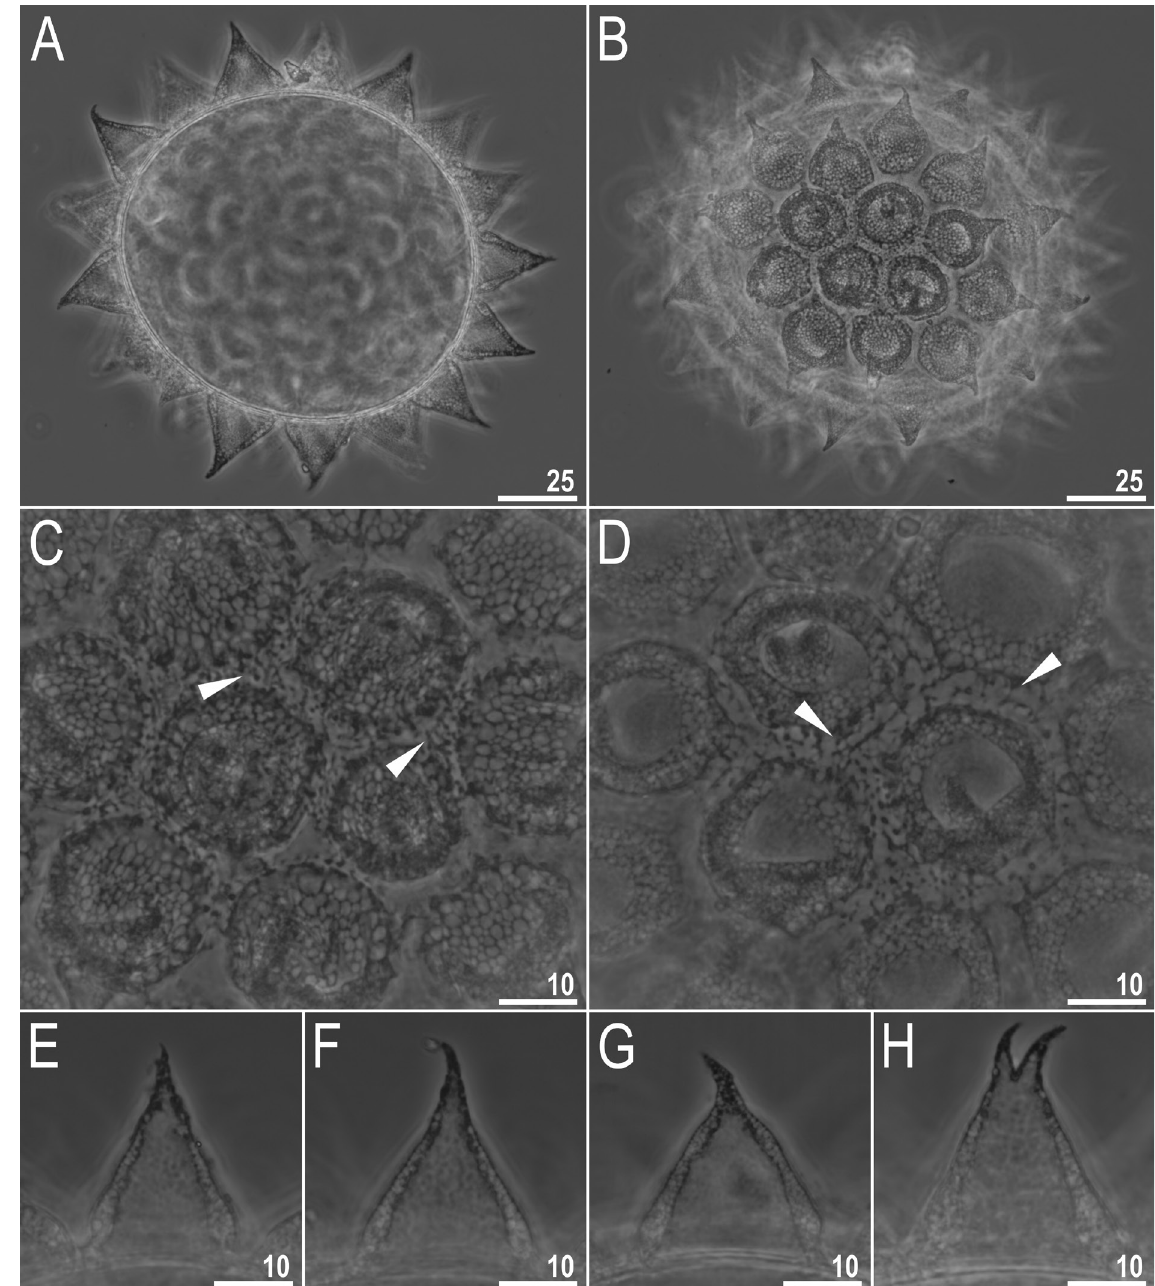
Fig. 18. Tenuibiotus zandrae sp. nov. Egg chorion morphology seen in PCM. A . Midsection under 400× magnification. B . Surface under 400× magnification. C – D . Surface between processes under 1000× magnification. E – H . Midsections of processes of four different eggs under 1000× magnification. Filled flat arrowheads indicate thickenings/striae which are visible as dark dots and lines on the surface between processes. Scale bars in